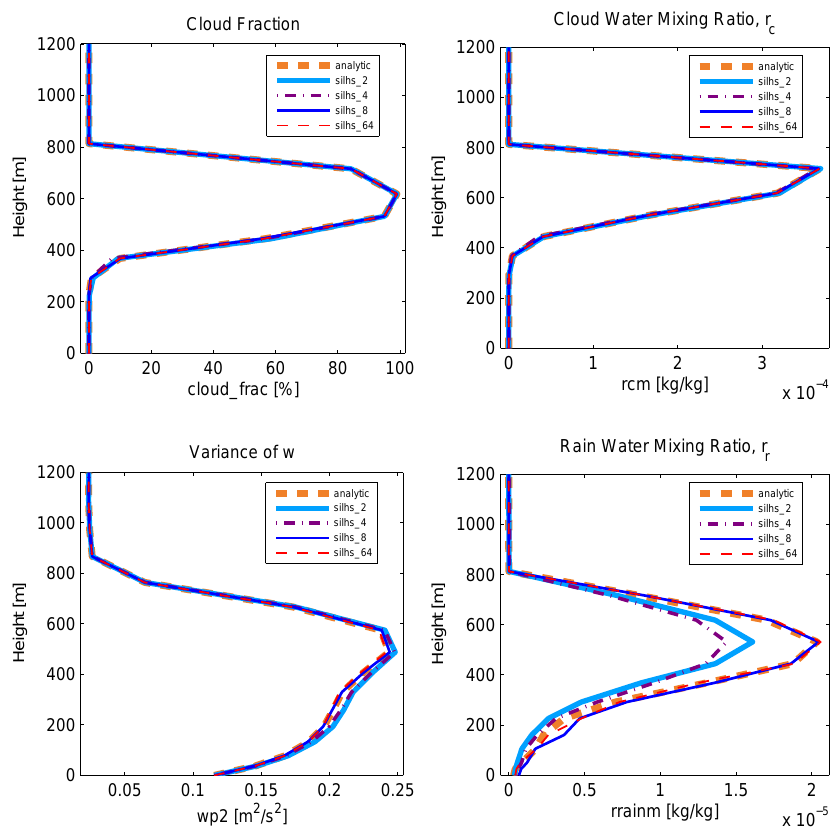
Fig. 4. As in Fig. 3, except for the DYCOMS-II RF02 marine stratocumulus simulation. Profiles are averaged over the full duration of the simulation (6 hours). Averaged over 6 hours, the noise manifested in the time series (Fig. 2) is considerably smoothed in all fields.